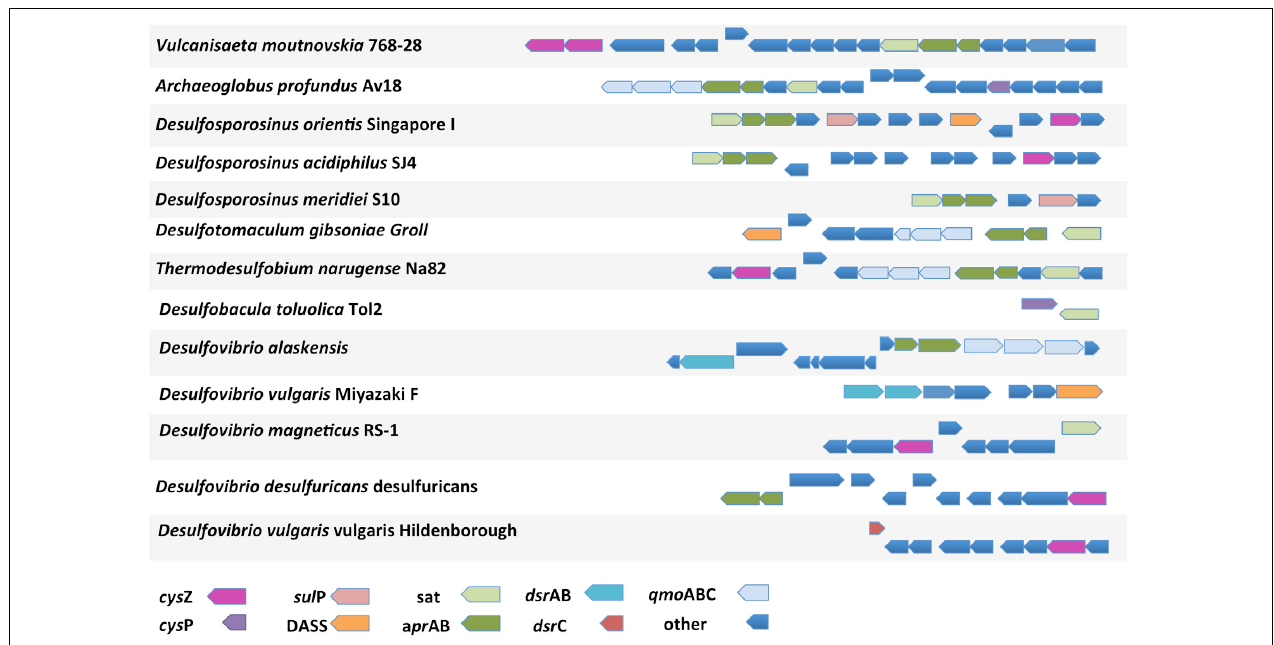
FIGURE 9 | The genomic location of putative sulfate transporter genes and their proximity to genes involved in the sulfate reduction pathway. sat , sulfate adenylyltransferase; apr A, adenosine-5 (cid:48) -phosphosulfate reductase alpha subunit; apr B, adenosine-5 (cid:48) -phosphosulfate reductase beta subunit; dsr AB, dissimilatory sulfite reductase alpha or beta subunit; dsr C, dissimilatory sulfite reductase C subunit; qmo ABC, quinone-modifying oxidoreductase subunit A, B, or C; other, unrelated to sulfate metabolism